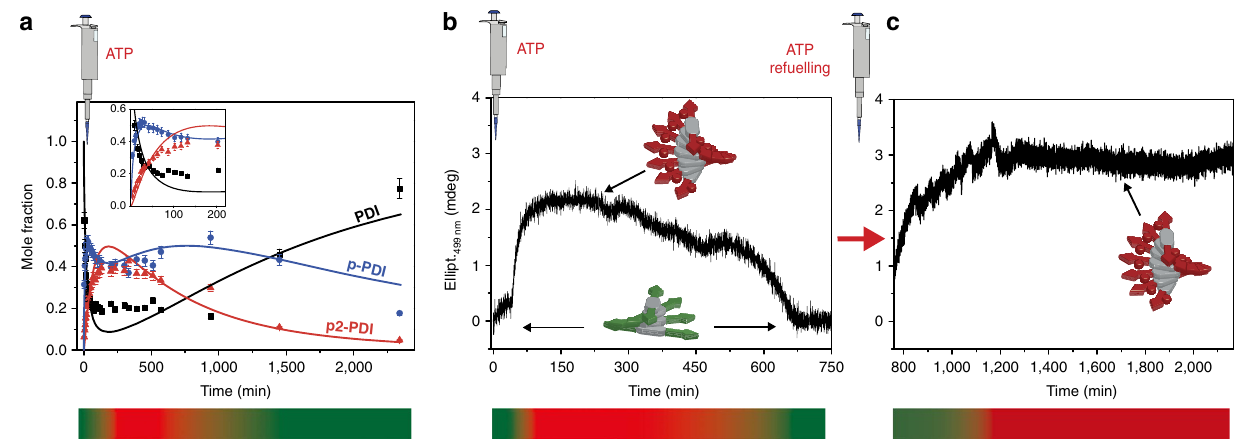
Figure 3 | Transient state and refuelling. ( a ) Molar fraction of PDI , p-PDI and p2-PDI versus time by LC–MS (points), following the batch addition of ATP (1mM), PKA (0.13 m M) and l PP (0.3 m M) to a 100 m M PDI solution. The solid lines are the fits of the ODE model. The insert is a zoom at the short times. ( b ) Time-course CD measurements (monitored at 499nm, optical path 1mm) following the batch addition of ATP (2mM) to a 200 m M PDI solution containing PKA (0.13 m M) and l PP (0.2 m M). The coloured bars at the bottom of a , b indicate the transient formation/disappearance of p2-PDI (red colour) starting from PDI (green colour). ( c ) Time-course CD measured after refuelling the same solution as in b with a second shot of ATP (2mM). In this case p2-PDI ( c ¼ 0.13 m M) and l PP ( c ¼ 0.3 m M).